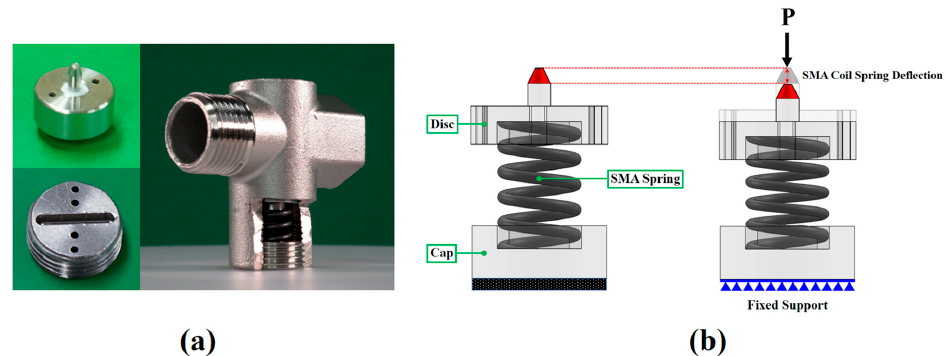
Figure 7. Application of fabricated SMA coil springs for anti-freezing system: ( a ) anti-freezing valves combined SMA coil springs; ( b ) schematics of the model and boundary conditions in structural analysis.